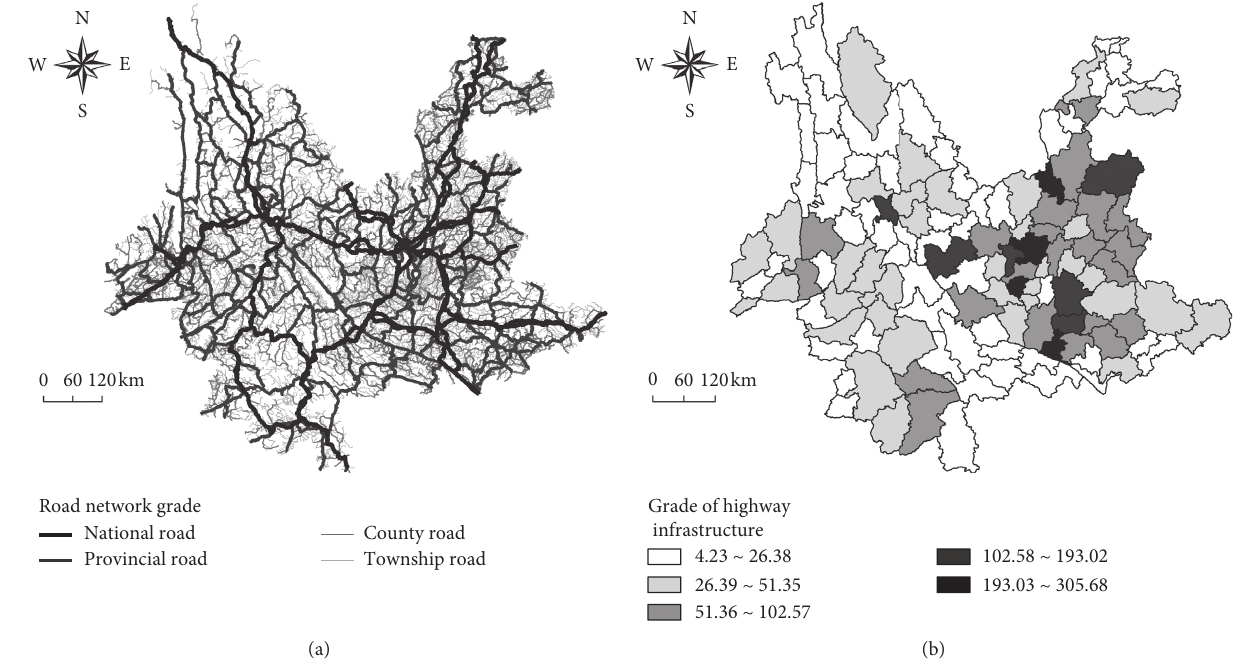
Figure 3: Spatial distribution of road infrastructure network and hierarchy. (a) Road network grade. (b) Road infrastructure